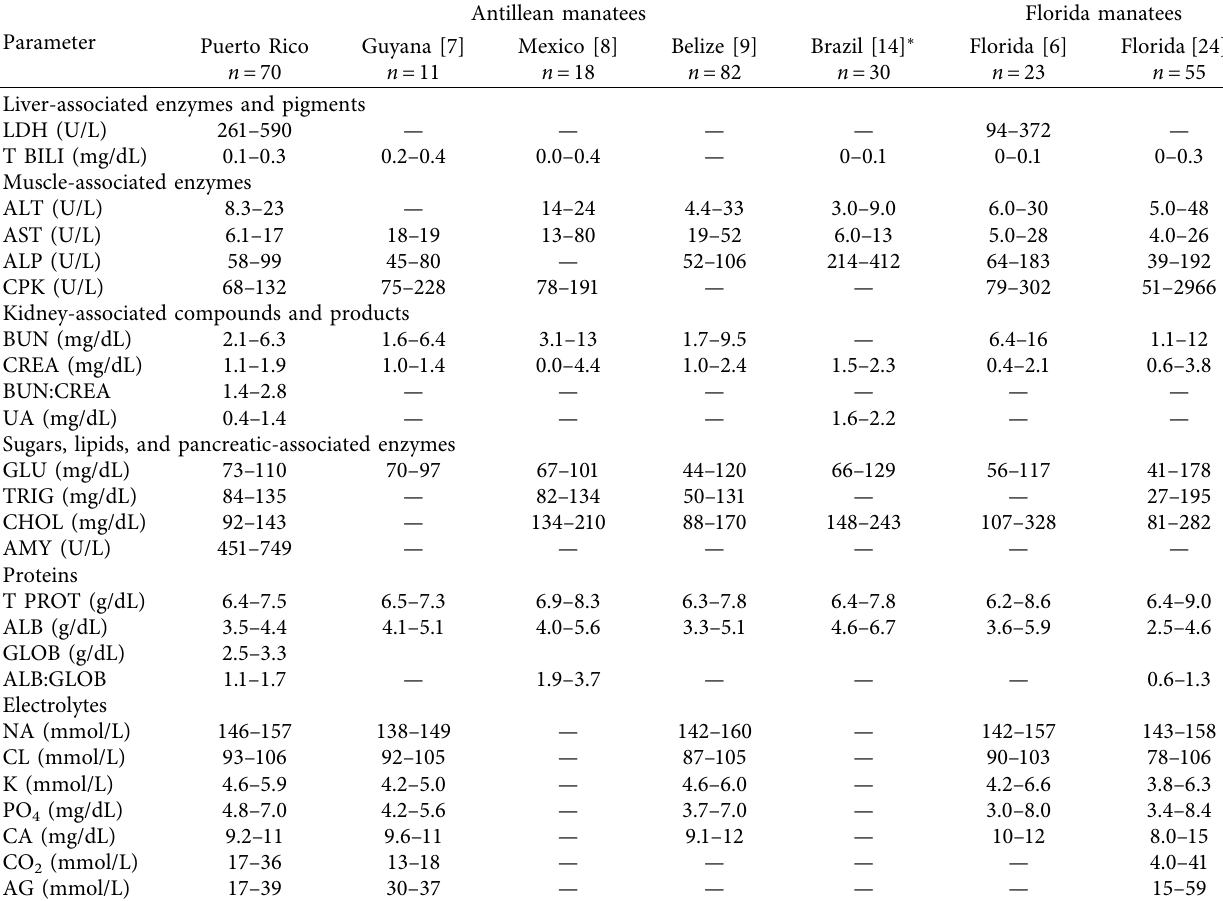
Table 7: Serum chemistry reference intervals for West Indian manatees from Puerto Rico, Florida, Guyana, Mexico, Belize, and Brazil. Puerto Rico values included all samples (calves, subadults, and adults). Abbreviations for parameters are detailed in the Materials and Methods section. Columns with an asterisk ( ∗ ) signify that the range values are minimum and maximum.